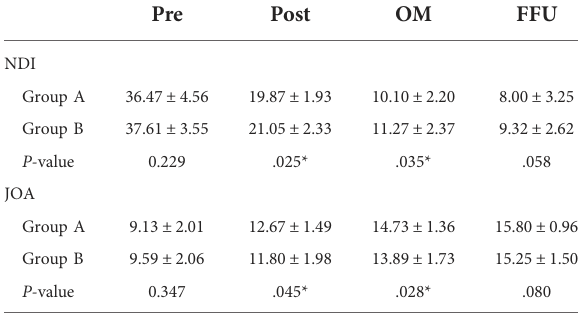
TABLE 2 Comparison of NDI and JOA scores between the two